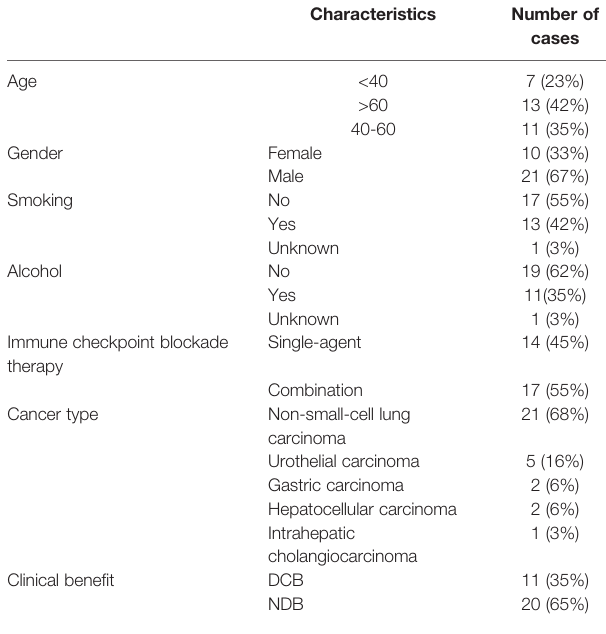
TABLE 1 | The demographic and clinical characteristics of 31 patients with anti- PD-1/PD-L1 treatment.